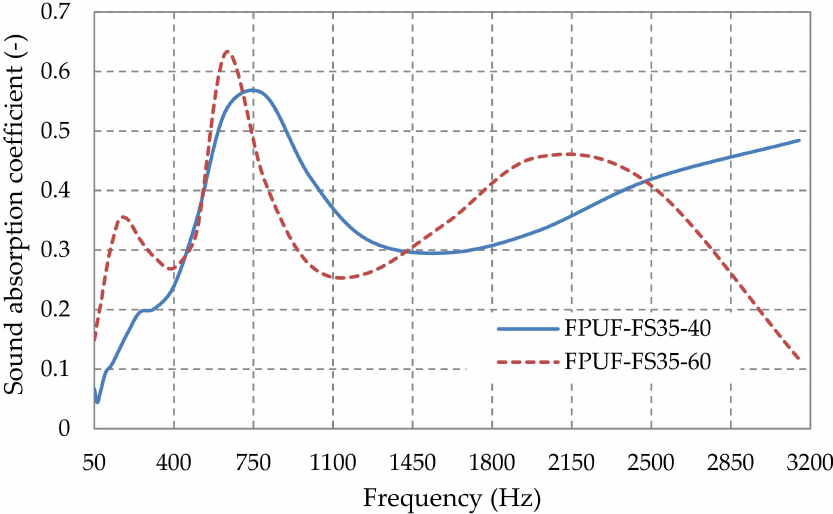
Figure 7. Sound absorption coefficient variation with plates thickness from flexible polyurethane foam with 35% fir sawdust.